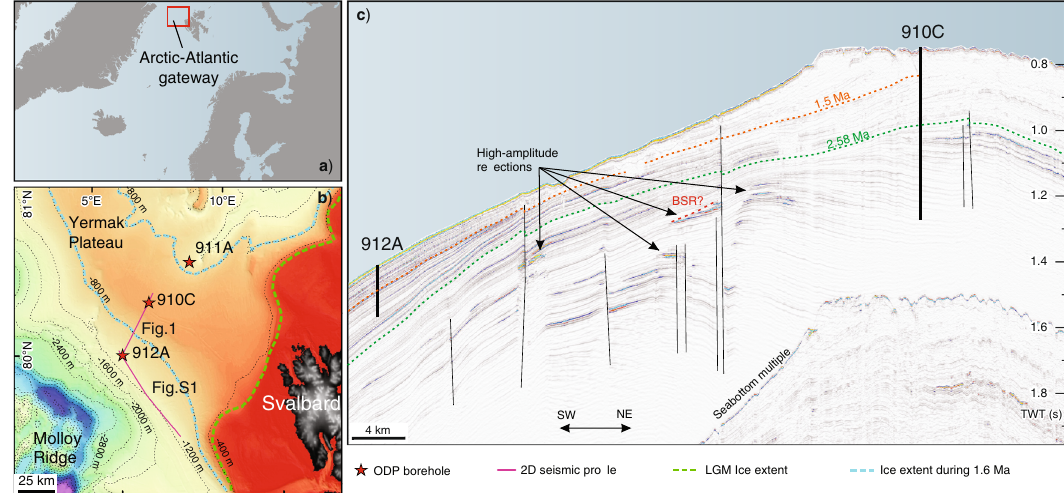
Fig. 1 ODP Leg 151 boreholes location and seismic data. a Map showing the Arctic – Atlantic gateway where the Yermak Plateau was drilled during ODP Leg 151 and the study area (red rectangle). b Bathymetry of the Yermak Plateau showing ODP Leg 151 boreholes and the location of the seismic pro fi le ( c ) used in this study crossing two holes: Hole 912A and Hole 910C. The ice extent during the Last Glacial Maximum (LGM) 91 and 1.6 Ma (assumed based on ref. 92 ) are shown in the fi gure with green and light blue dotted lines, respectively. c The seismic data show the BSRs and gas-charged sediments visible as high-amplitude re fl ections. Age markers 1.5 (orange dotted line) and 2.58 Ma (green dotted line) are adopted from previous studies 29 . Fig. S1 refers to Supplementary Fig.